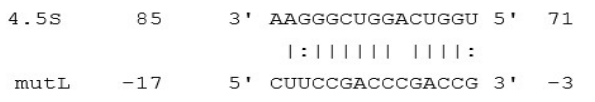
third base upstream of the adenosine of the AUG codon.